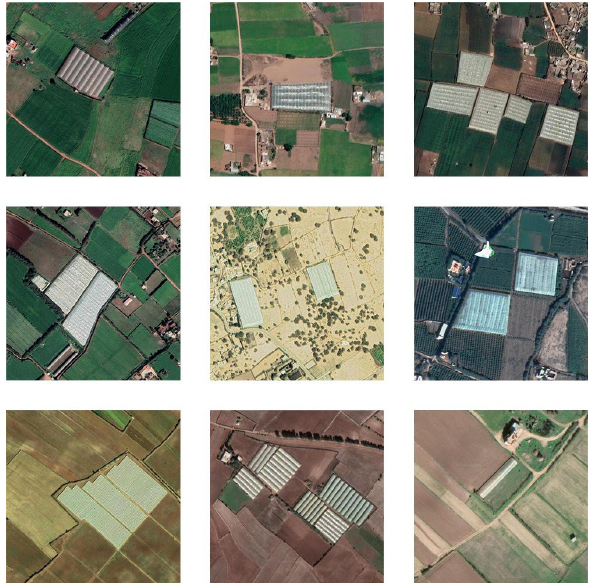
Figure 3: Some of the images used in the study